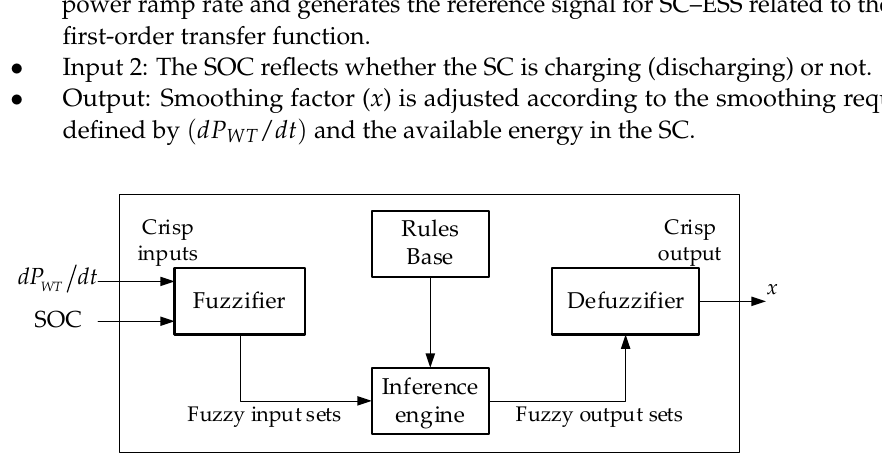
Figure 6. Schematic representation of the fuzzy logic controller.